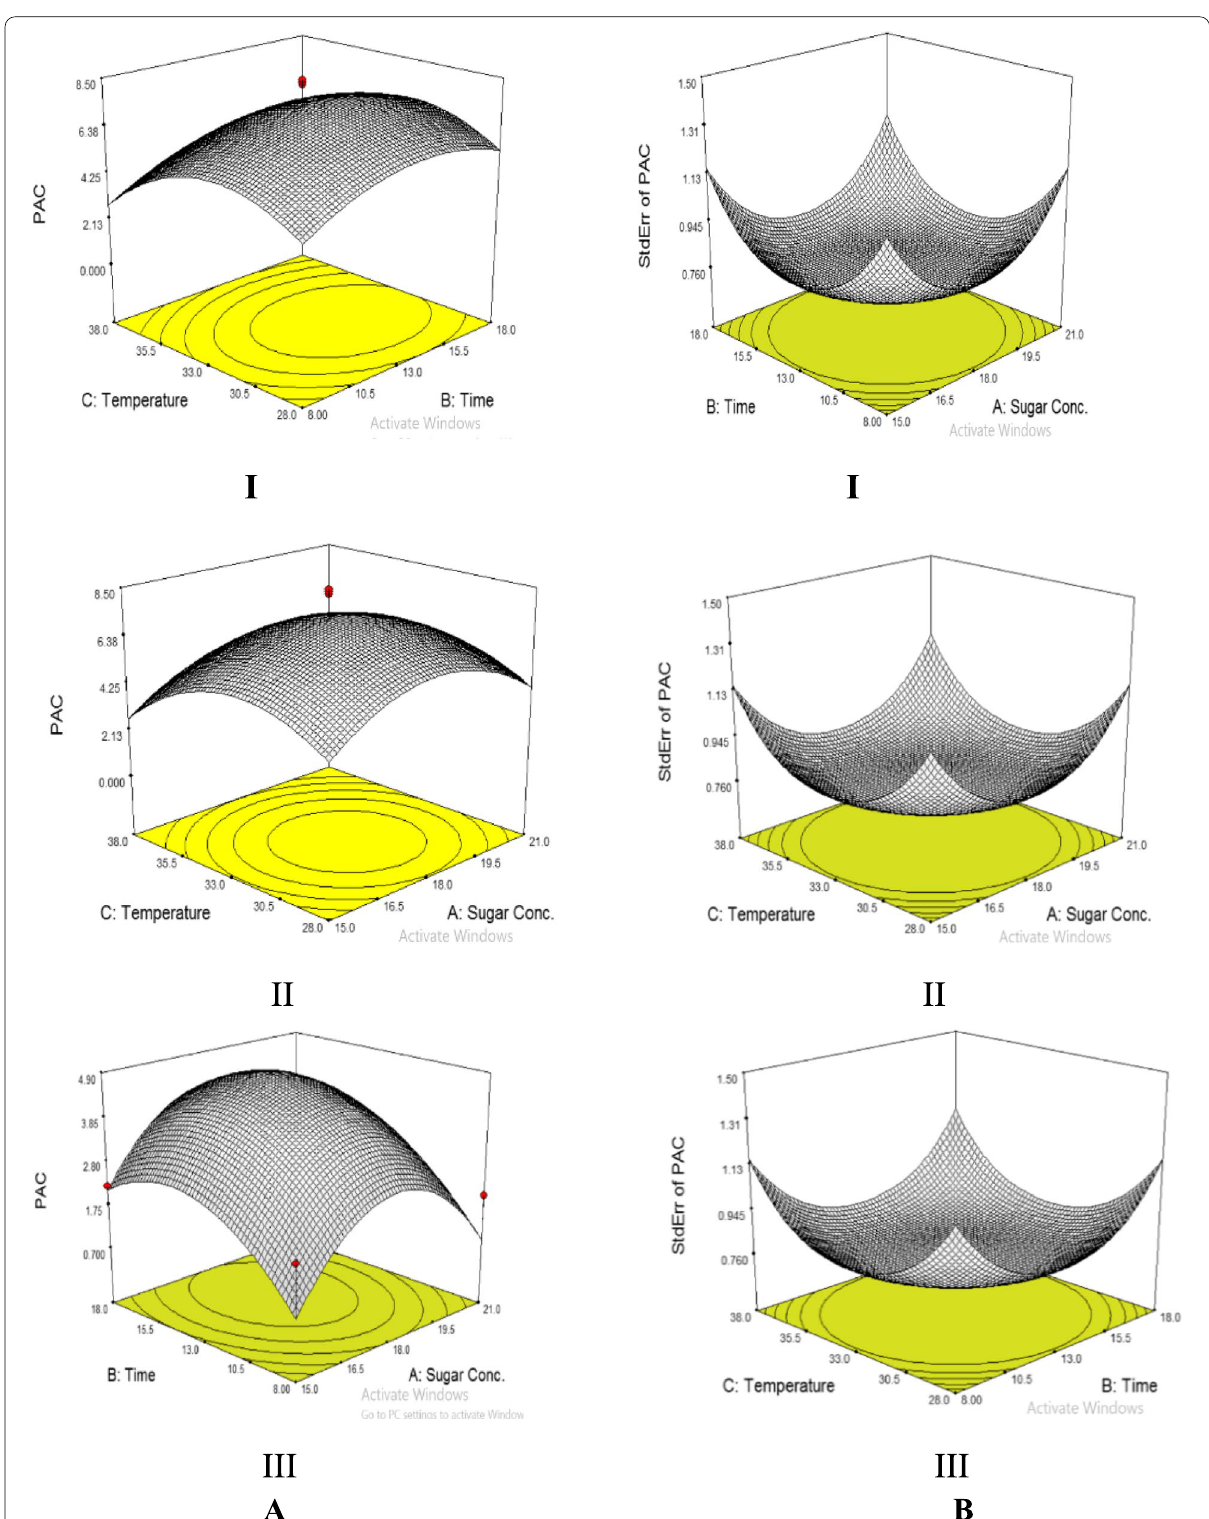
Fig. 5 A Effects of corelation of time and sugar conc., temperature and sugar conc., and temperature and time on PAC produced (g/l). B Standard error of co-interaction of time and sugar conc., temperature and sugar conc., and temperature and